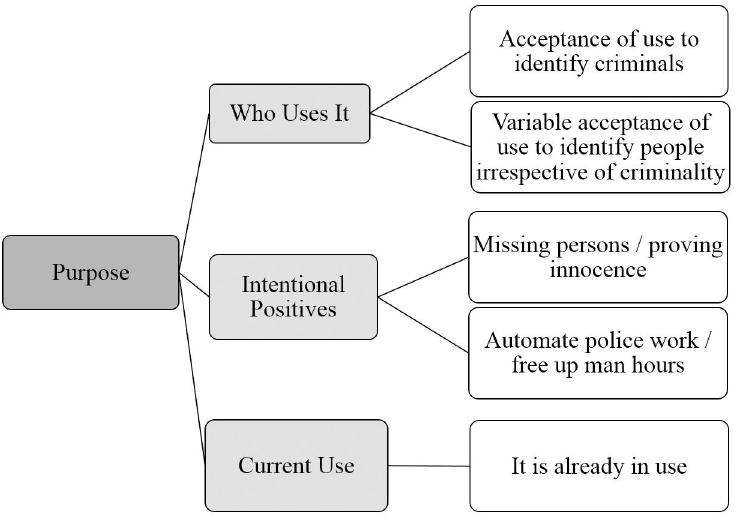
Fig 4. Purpose overarching theme. Graphical representation of Purpose overarching theme and its component themes and subthemes identified from focus groups conducted in the UK, Australia and China.